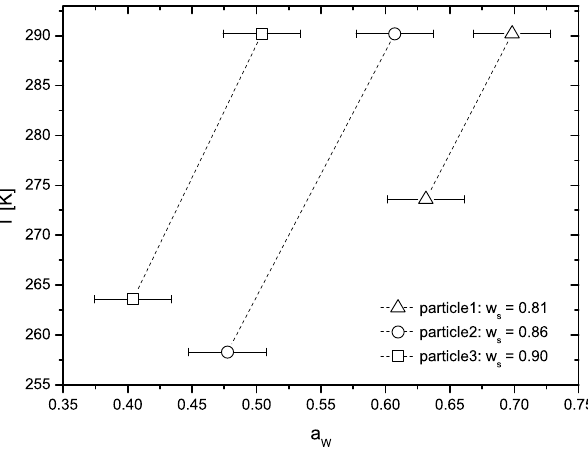
Figure 7. Temperature vs. a w for three different shikimic acid parti- cles at fixed concentrations (as indicated in the legend). The dashed lines serve only as a guide to the